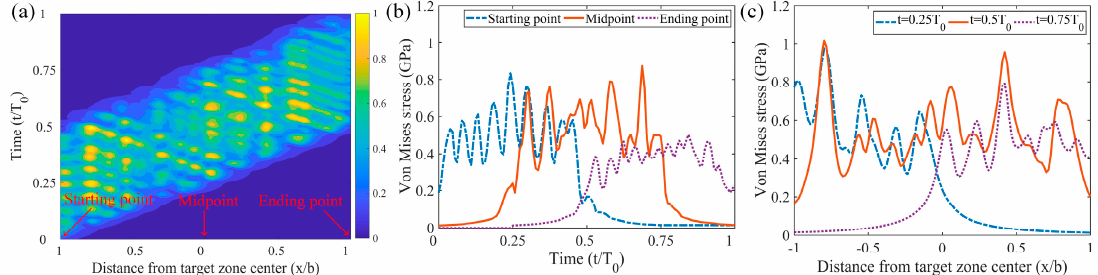
Figure 7. Stress history during a rolling–sliding contact, ( a ) von Mises stress distribution, ( b ) stress-time plots, ( c ) stress-position plots.